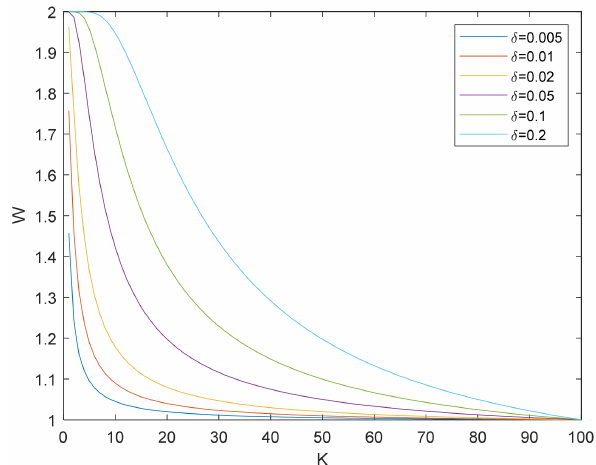
Figure 3. MHTW curves under different